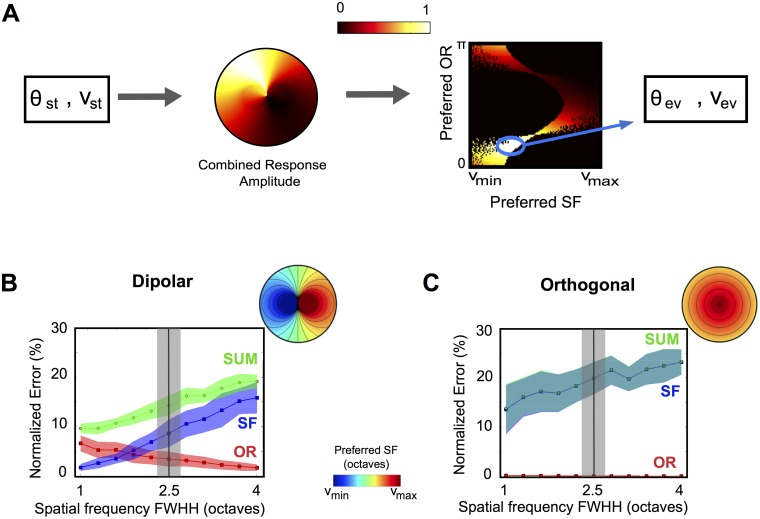
Decoding an OR and SF stimulus, and balanced detection at PCs.(A): Decoding algorithm: the activity map in response to a stimulus (θ
st, ν
st) is represented in the parameter space of preferred (OR, SF). An estimated stimulus (θ
ev, ν
ev) is obtained by the weighted average of the 10% highest response amplitudes. (B): Median error (in %± mad) in the detection of OR (red), SF (blue) and OR + SF (green), for the dipolar structure as a function of the FWHH for the SF tuning curve (in octaves). The FWHH for the OR tuning curve is set at y
exp = 80°. The gray bar corresponds to the experimental variability of the SF tuning [16] of the whole map. One example of the SF maps considered is shown on the top-right corner. (C): The same as (B) for the orthogonal architecture.